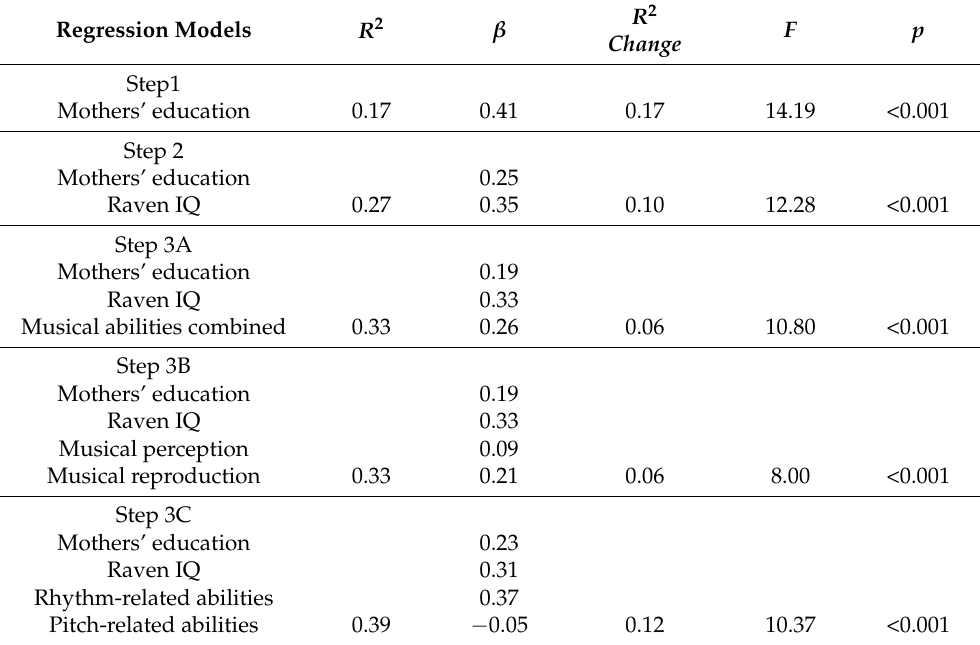
Table 3. Hierarchical regression models with GPA as the dependent